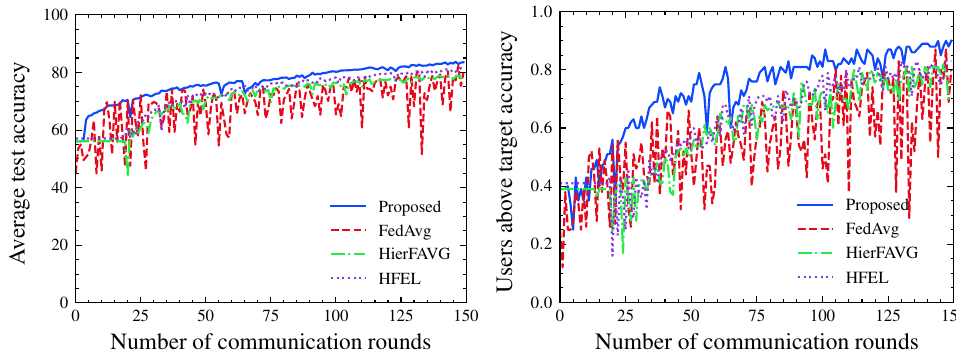
Figure 6. Performance comparisons of the various FL algorithms in Sent140